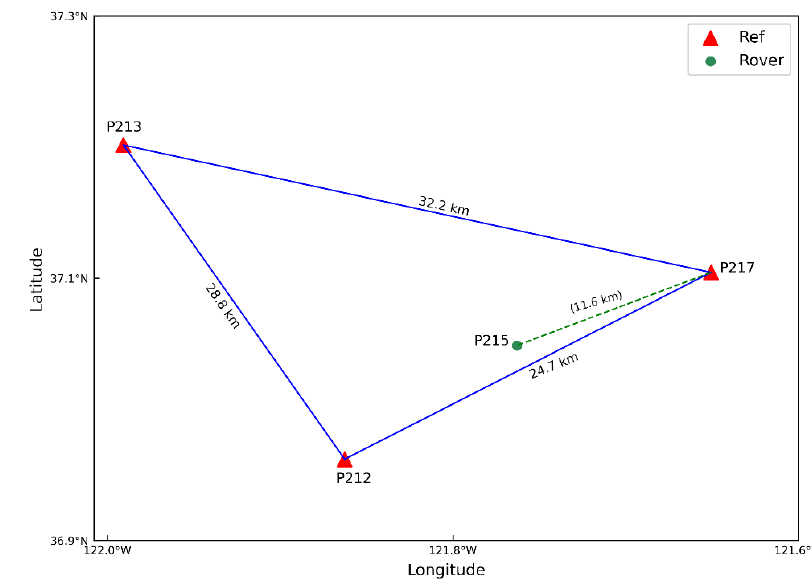
Figure 1. The distribution of experimental dataset 1 stations.